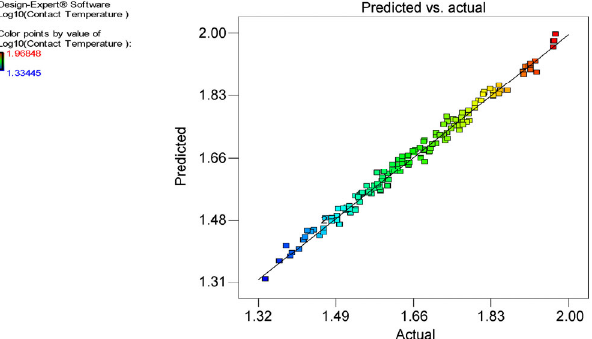
Fig. 17 Predicted as a function of actual response values for maximum contact temperature.